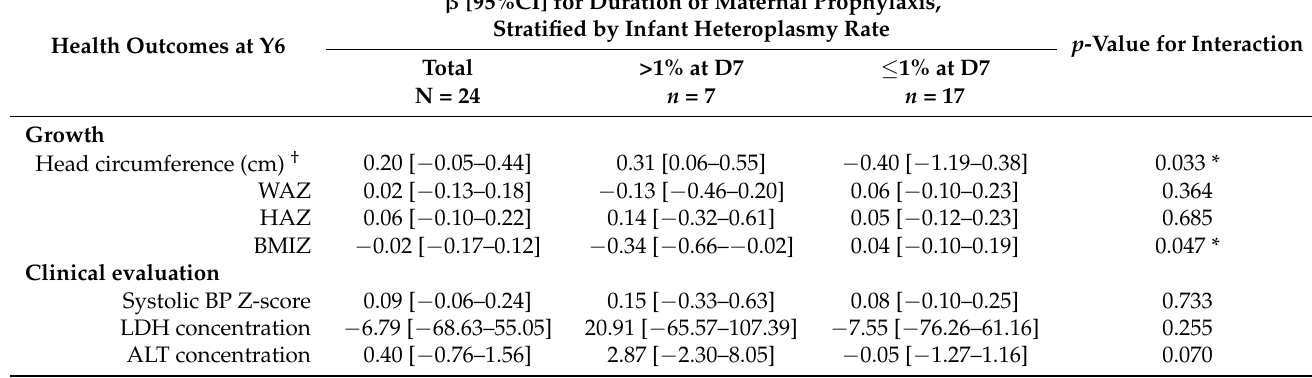
Table 6. Association between the duration of maternal prophylaxis during pregnancy and poor health outcomes at Y6, stratified by infant heteroplasmy rate (>1% or ≤ 1%) at